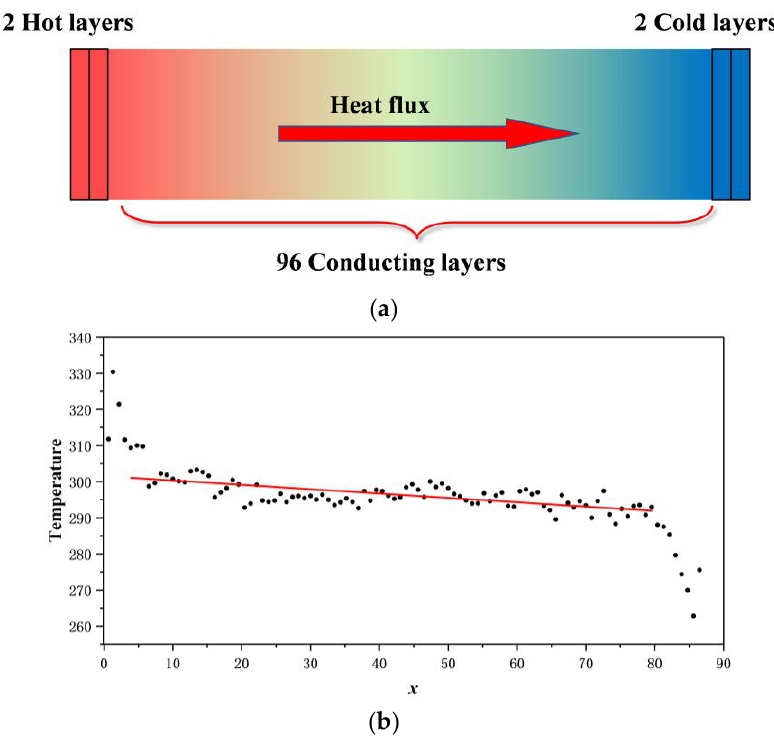
Figure 3. NEMD method for thermal conductivity: ( a ) Schematic diagram of simulation; ( b ) the temperature distribution in the simulation domain and line fitting.